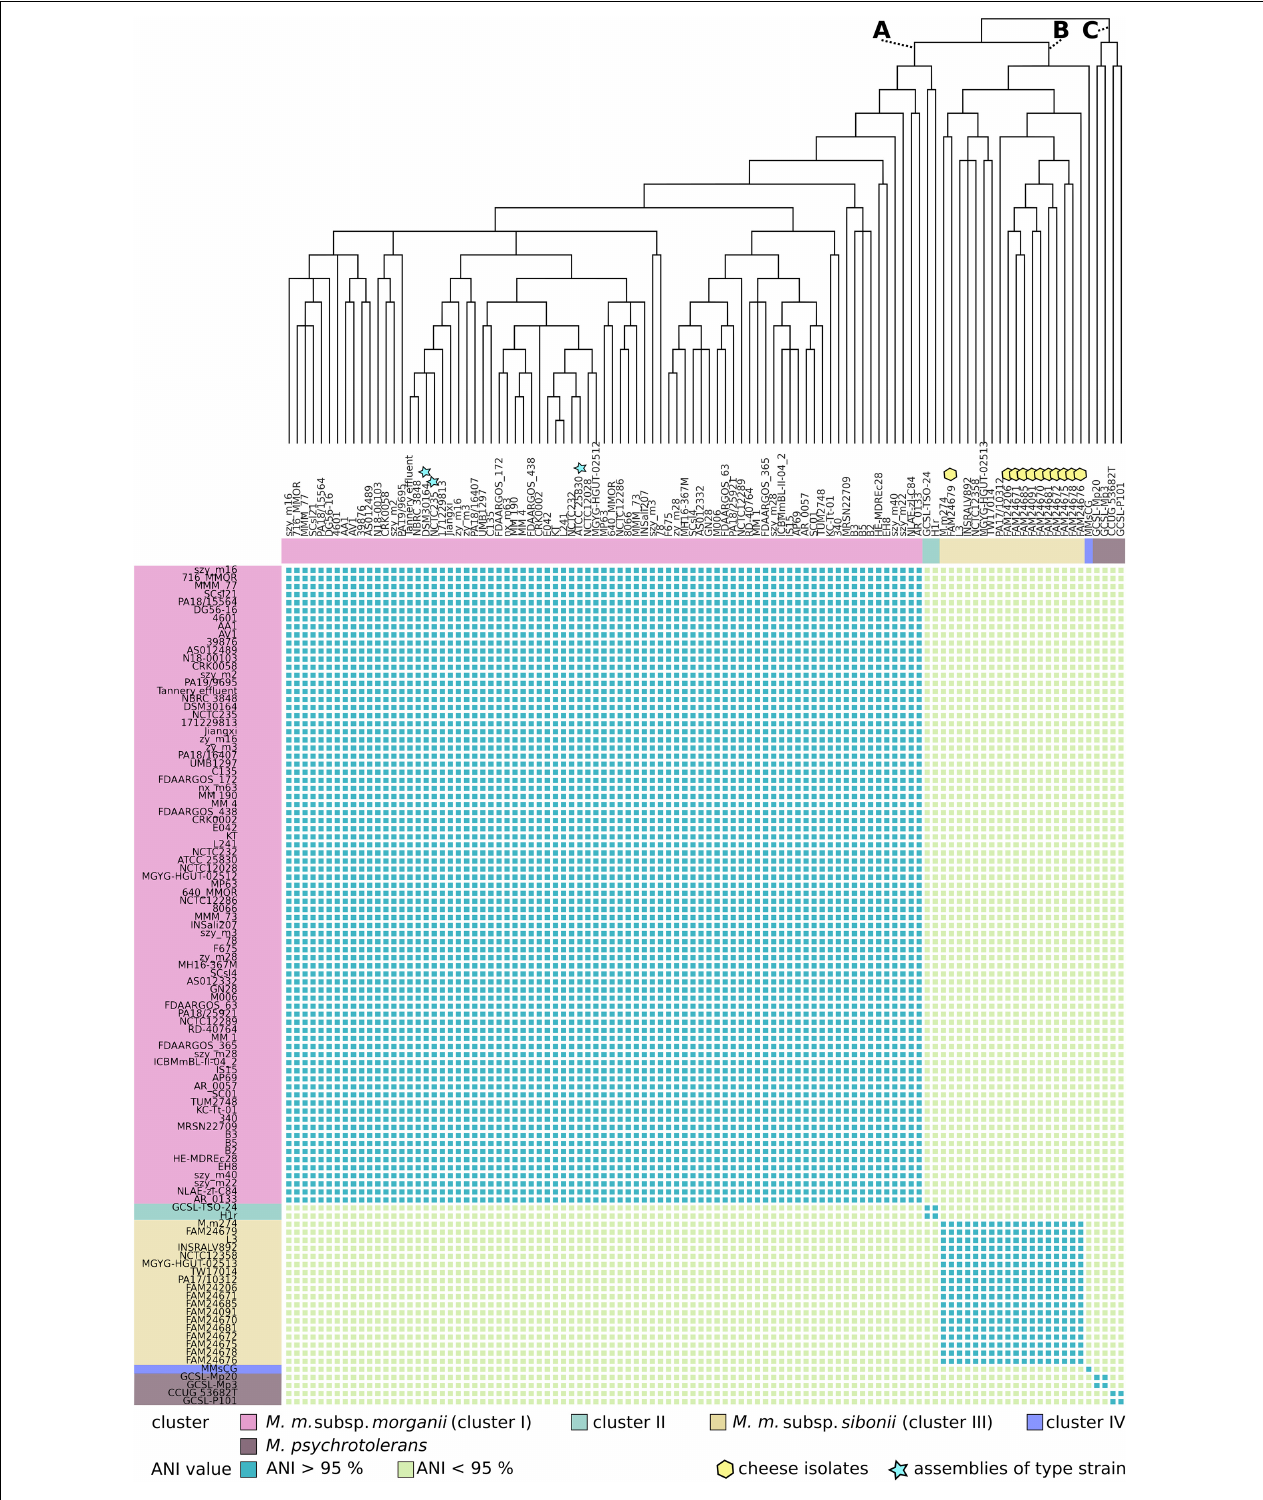
FIGURE 2 | The upper part of the figure displays a phylogenetic core gene tree of 100 M. morganii (M. m.) and four M. psychrotolerans genomes. The tree was inferred based on maximum likelihood and branches with bootstrap values below 70% were collapsed. A, B, and C mark the three main branches of the tree. The heat map in the lower part of the figure shows the pairwise whole genome average nucleotide identity (ANI) values. An ANI value cut-off of 95% separates the M. morganii genomes into the clusters I, II, III, and IV.